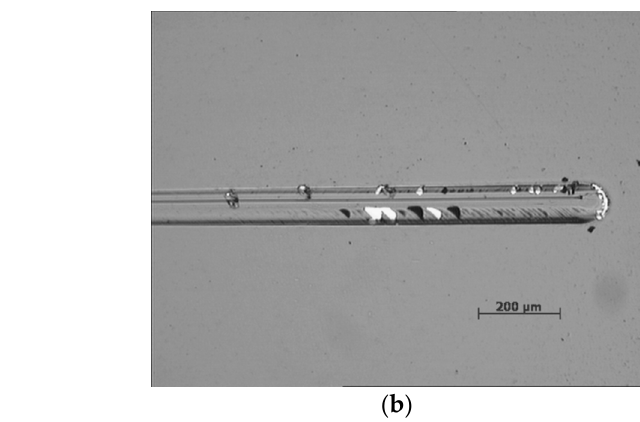
( b ) Figure 3. Raman analysis of the coatings deposited with different CH 4 flows: ( a ) G position and FWHM (G) and ( b ) ID/IG . In relation to the G peak position, according to Ferrari and Robertson [16], a shift in the G peak to lower wave numbers is related to bond disorder while the inverse is related to chain formation or clustering. These factors act as competing forces on the shape of the